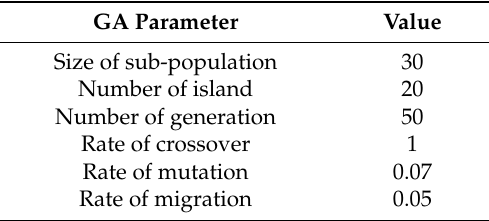
Table 5. Genetic algorithm (GA)